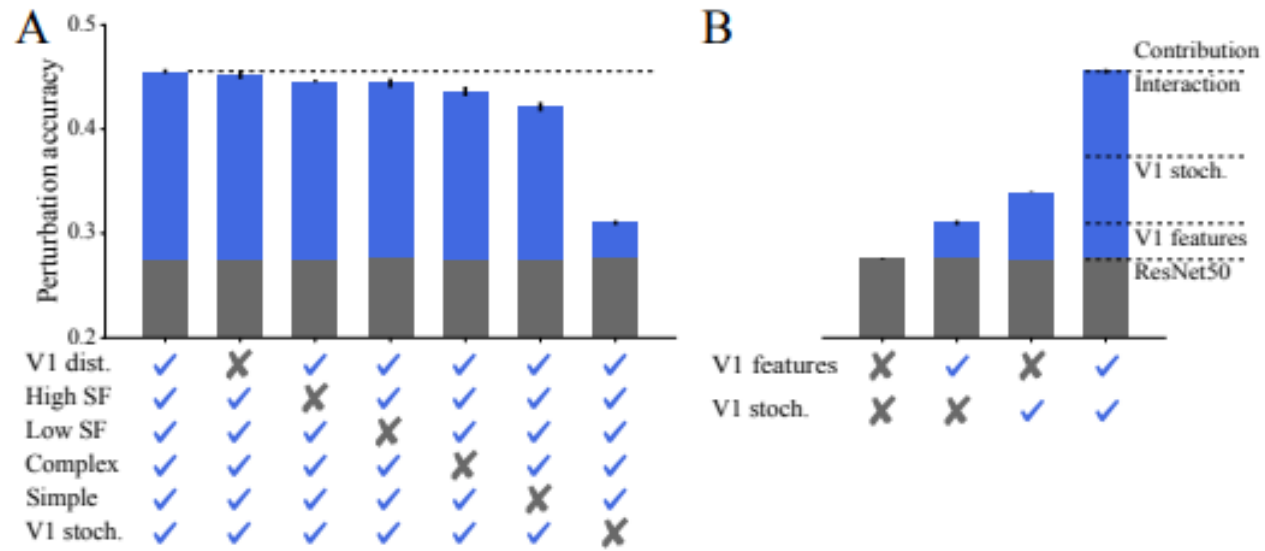
Figure 31. ( A ) All the components of VOneBlock contributed to the robustness of the model against adversarial attacks in a robustness test against PGD attacks when ResNet-50 was used as the base model. ( B ) the performance changes in absent of stichasticity in V1 feature.